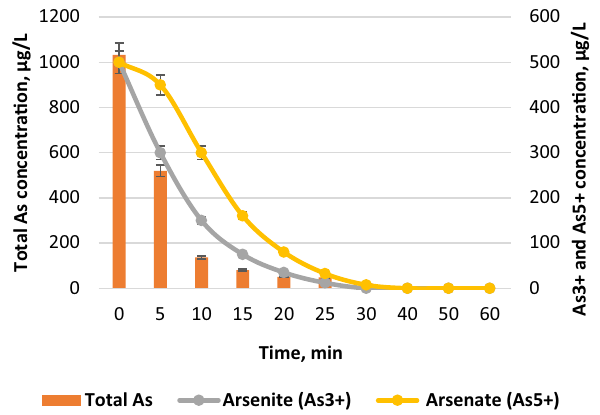
Fig. 4 Variation of As 3+ and As 5+ concentrations compering total As during EC treatment